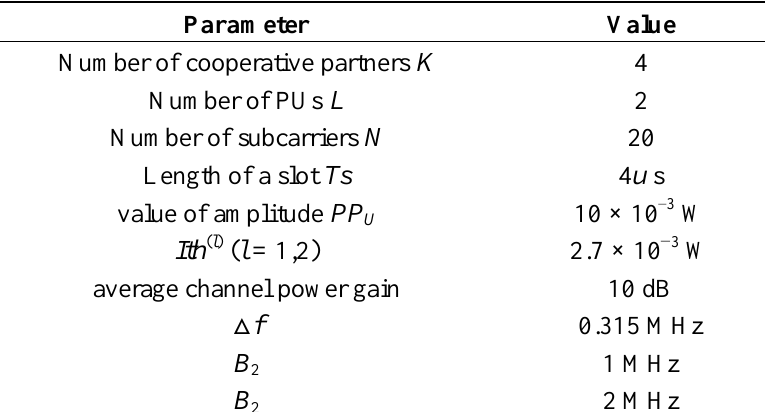
Table 3. Simulation